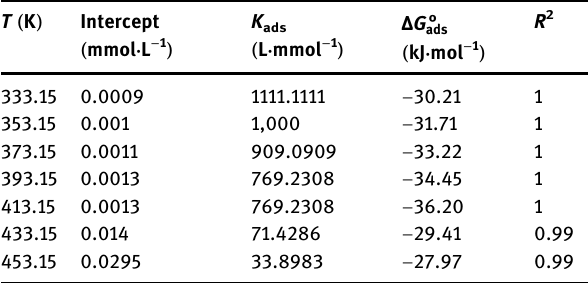
Table 2: The isotherm fi tting parameters T ( K ) Intercept ( mmol · L − 1 )